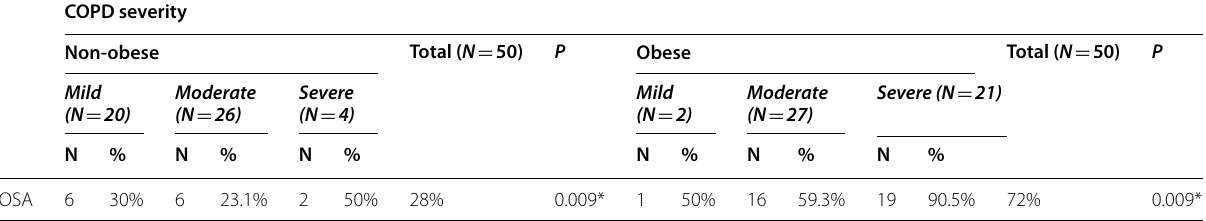
Table 4 Prevalence of OSA among obese and non-obese COPD patients COPD severity